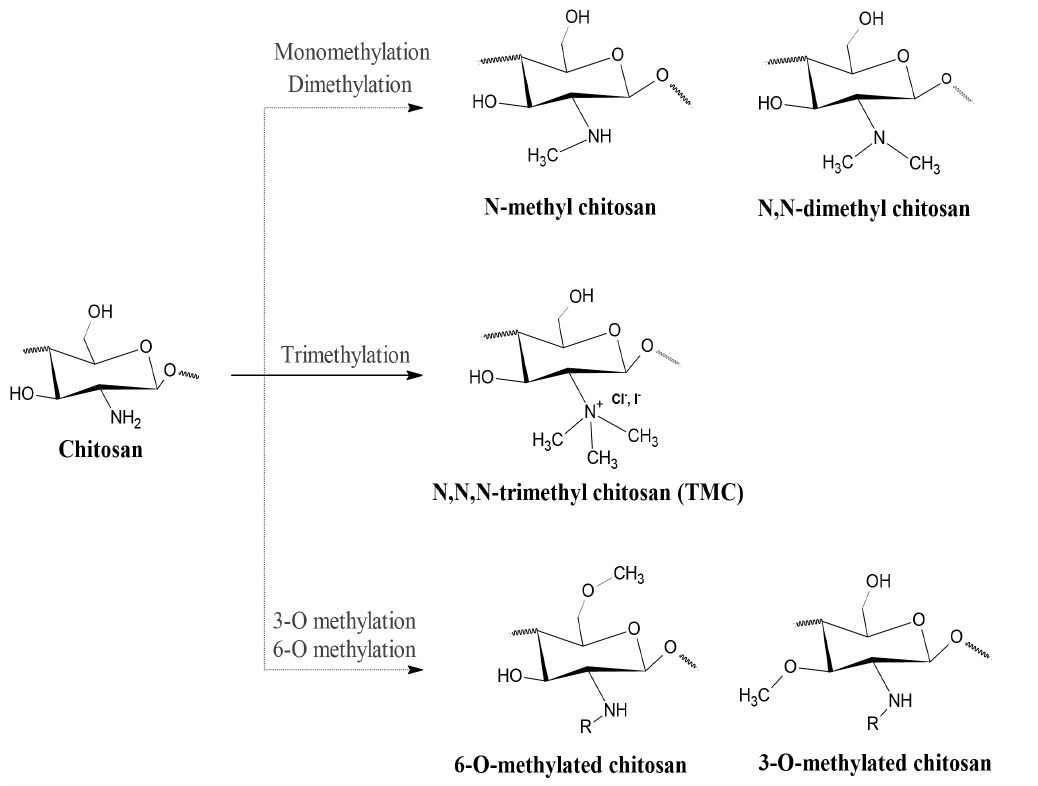
Figure 1. Chitosan, N,N,N-trimethyl chitosan (TMC) and its N-methylated and N,O-methylated